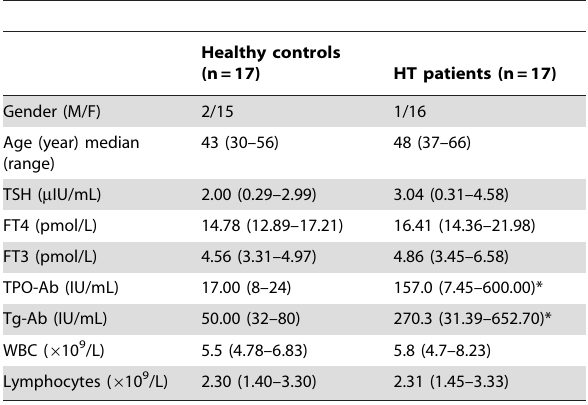
Table 1. The demographic and clinical characteristics of the